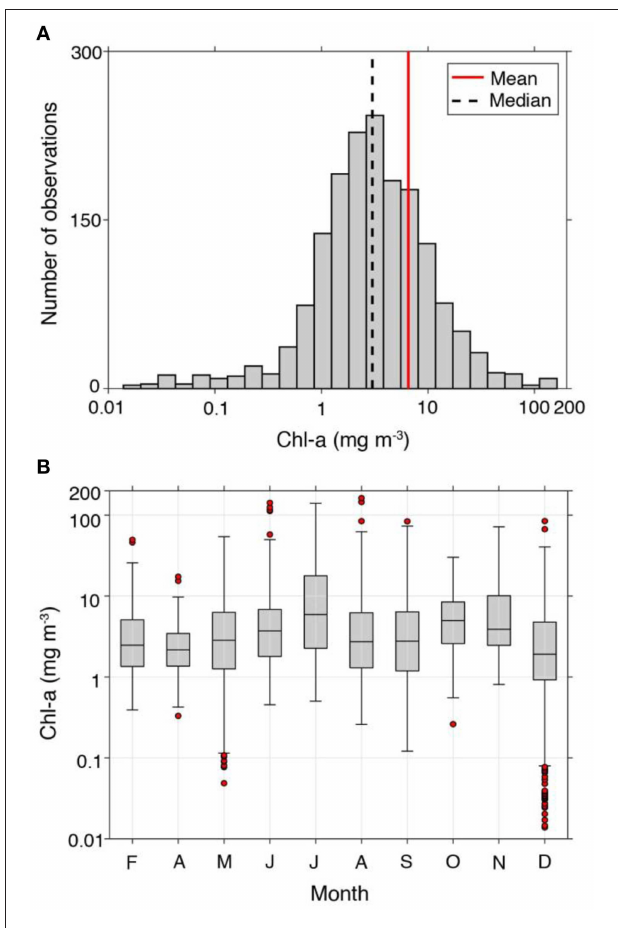
FIGURE 2 | In situ Chl-a observations. (A) Histograms of in situ Chl-a (mg m − 3 ). The black dashed and red solid lines indicate median and mean values, respectively. (B) Box plot of monthly in situ Chl-a (mg m − 3 ) for the study period (2011–2016). Box plot in (B) depicts median (horizontal line), interquartile range (box), 1.5 × interquartile range (error bars), and outliers (red dots) that fall more than 1.5 times the interquartile range below the first quartile or above the third